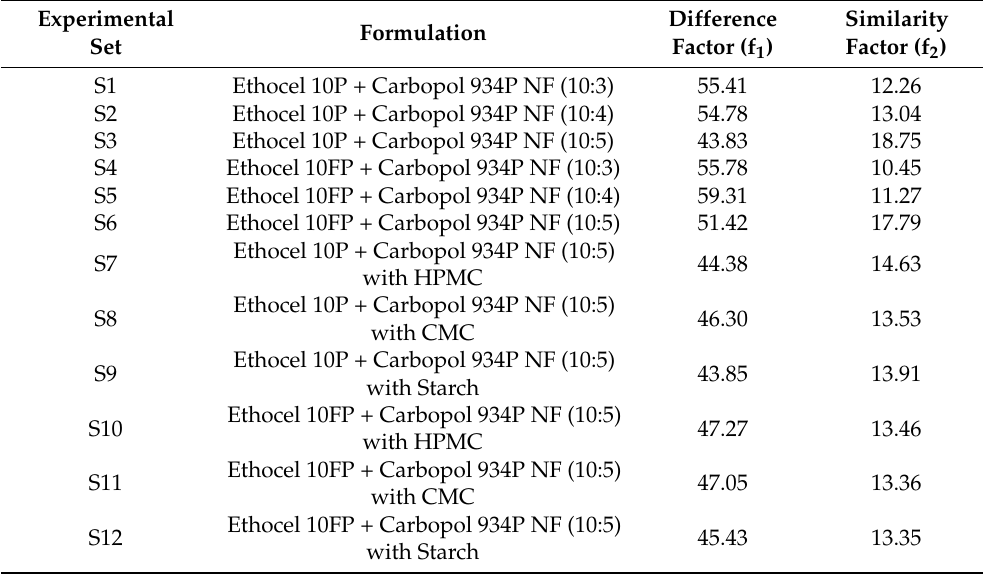
Table 6. Drug release comparison between the tested matrices and commercial, traditional release losartan potassium tablets (Cardaktin ®